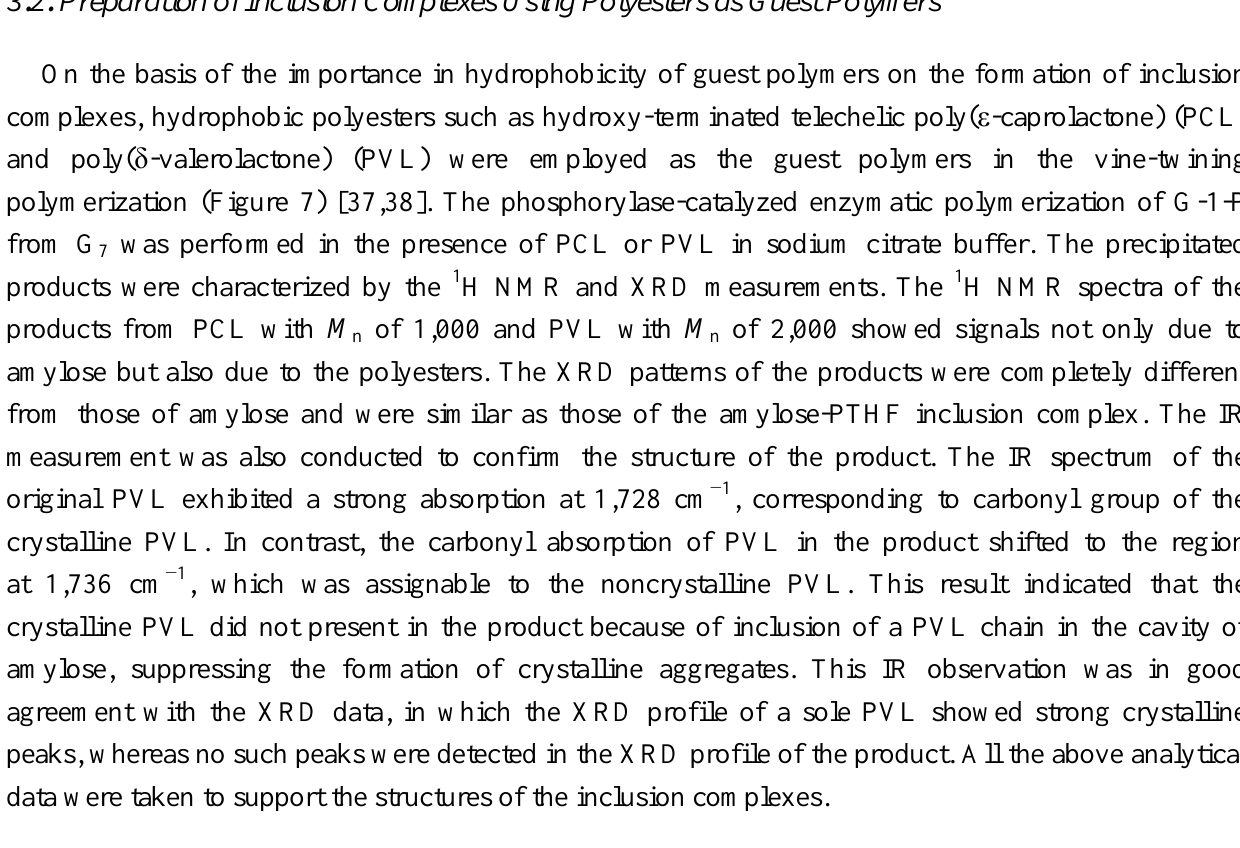
Figure 7. Preparation of inclusion complexes by vine-twining polymerization using hydrophobic guest